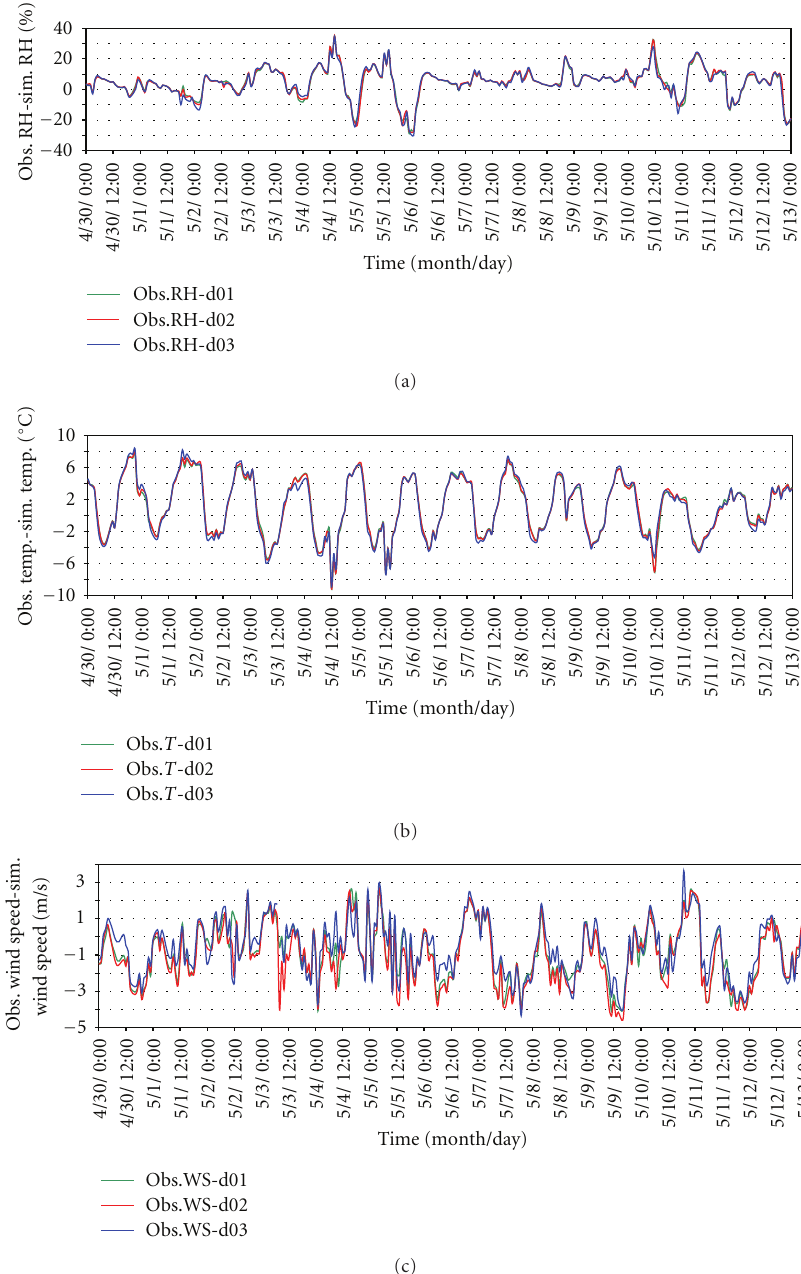
Figure 5: Comparison of di ff erence between observed and estimated (at di ff erent domain resolutions) temperature, wind speed and direction, and relative humidity for station